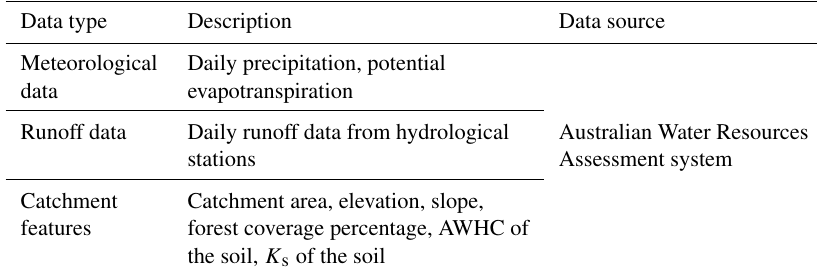
Table 1. Description of the dataset adopted in this study.